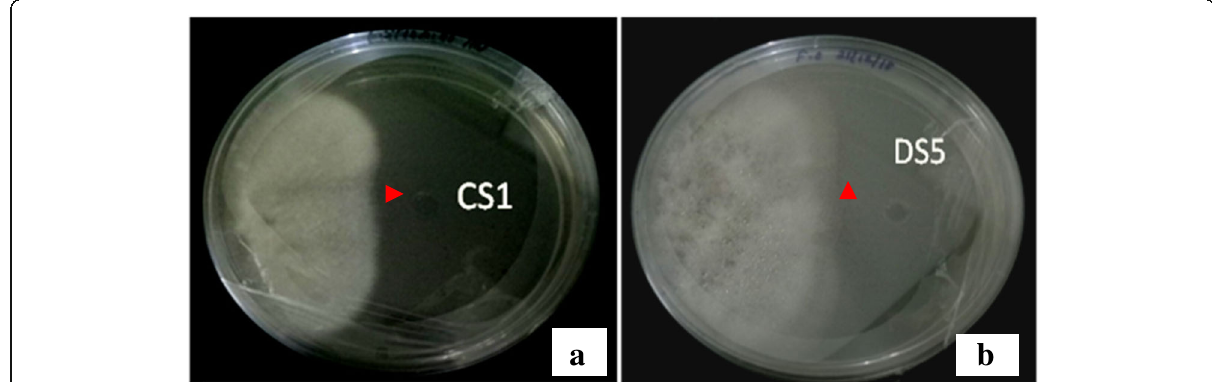
Fig. 3 Dual culture assay of antifungal activity of bacterial endophytes (arrows indicate wells). a CS1 isolated from Chirata against fungal pathogen ( F . oxysporum ). b DS5 isolated from Datura against fungal pathogen ( F . solani